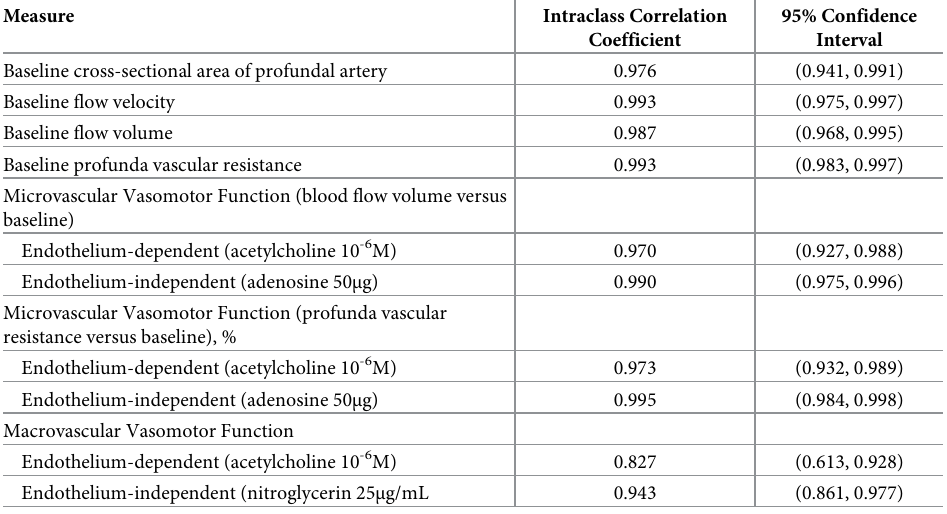
Table 3. Reproducibility over 6 months of vascular function assessed by intraclass correlation coefficients.